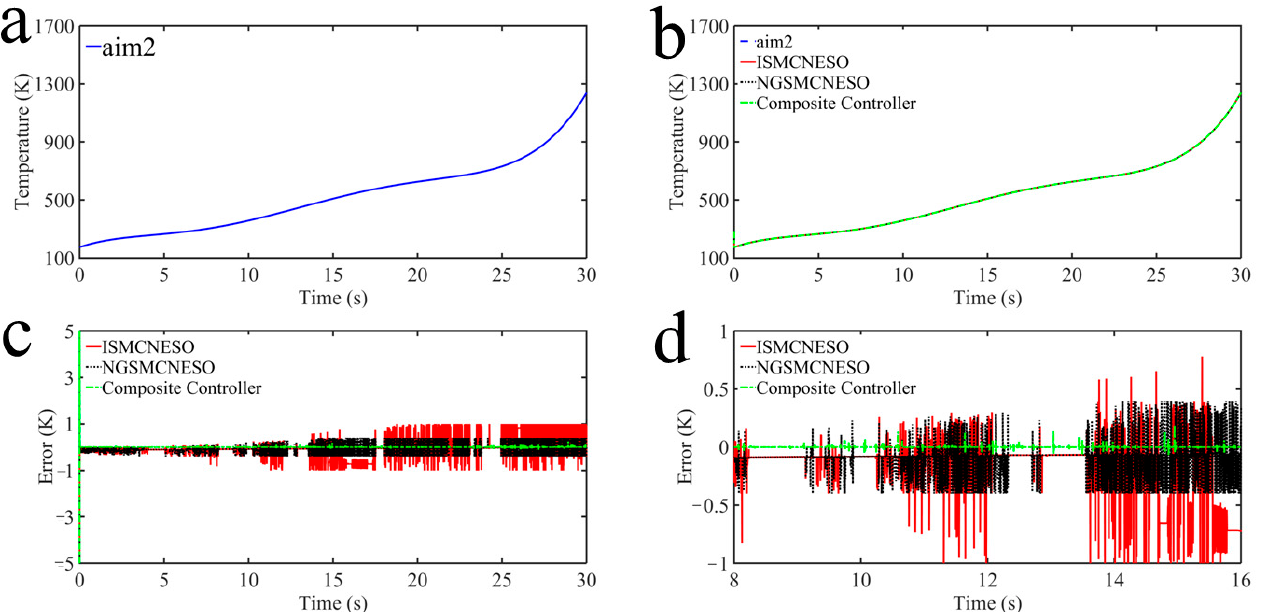
Figure 15. Simulation results: ( a ) the fitting curve of the reference temperature trajectory from Wall 0_3 mm; ( b ) the reference temperature tracking performance among ISMCNESO controller, NGSMCNESO controller, composite controller; ( c ) the tracking errors; ( d ) their partial enlarged figures in details.